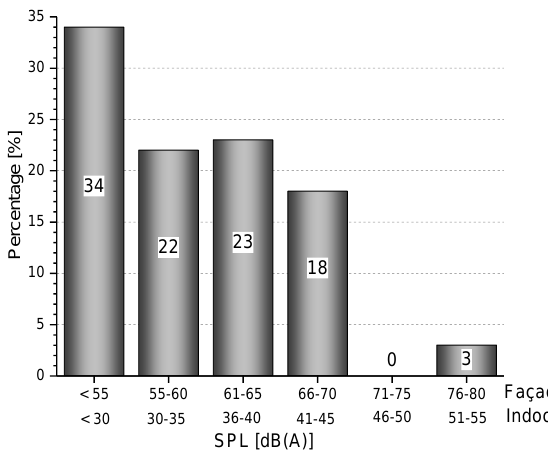
Figure 10. Distribution of the facade SPL (L Aeqd, 8 – 17 h ) and of the indoor SPL (L Aeqd, 8 – 17 h ) to which the students of primary and lower secondary schools of Florence were exposed.